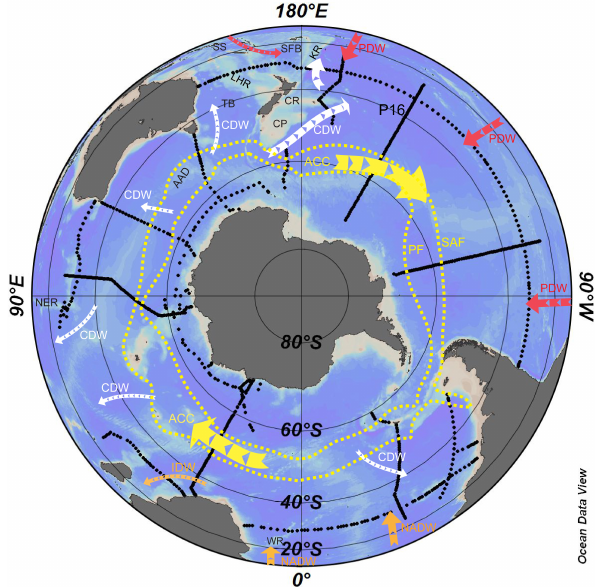
Fig. 1. Map of the Southern Hemisphere oceans with the major to- pographic features labelled, which are discussed in the text: SS – Solomon Sea, SFB – South Fiji Basin, LHR – Lord Howe Rise, TB – Tasman Basin, KR – Kermadec Ridge, CR – Chatham Rise, CP – Campbell Plateau, WR – Walvis Ridge, NER – Ninety East Ridge, AAD – Australian–Antarctic Discordance. The main deep oceanographic flows into and out of the Southern Ocean are also il- lustrated with large arrows. North Atlantic Deep Water (NADW; orange), Indian Deep Water (IDW; orange), Pacific Deep Water (PDW; red) and Circumpolar Deep Water (CDW; white). The lo- cations of the Southern Ocean fronts are also shown. Subantarc- tic Front (SAF; yellow dashed line) and Polar Front (PF; yellow dashed line) adapted from Sokolov and Rintoul (2009) and the full depth Antarctic Circumpolar Current (ACC; yellow arrows). The WOCE/CLIVAR stations used in this study are shown by the black dots, with the P16 transect, used in Figs. 2 and 4, highlighted in the middle of the South Pacific